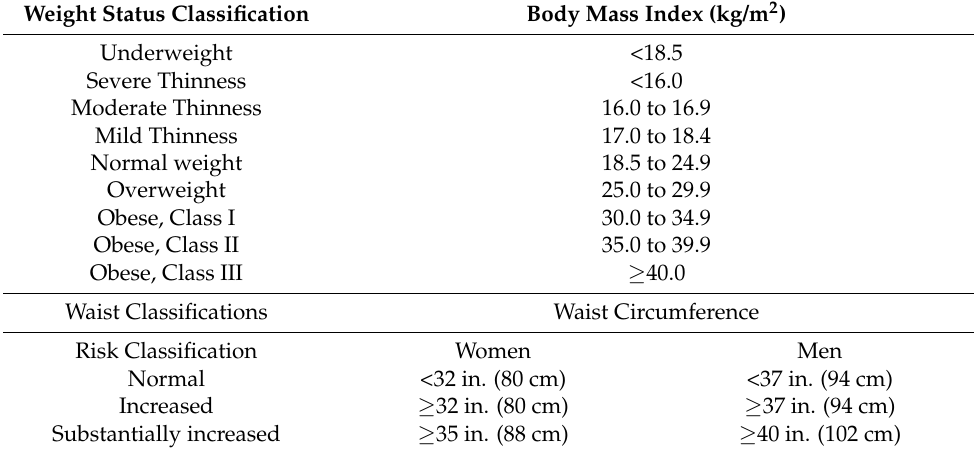
Table 1. Body mass index and waist circumference classifications. Weight Status